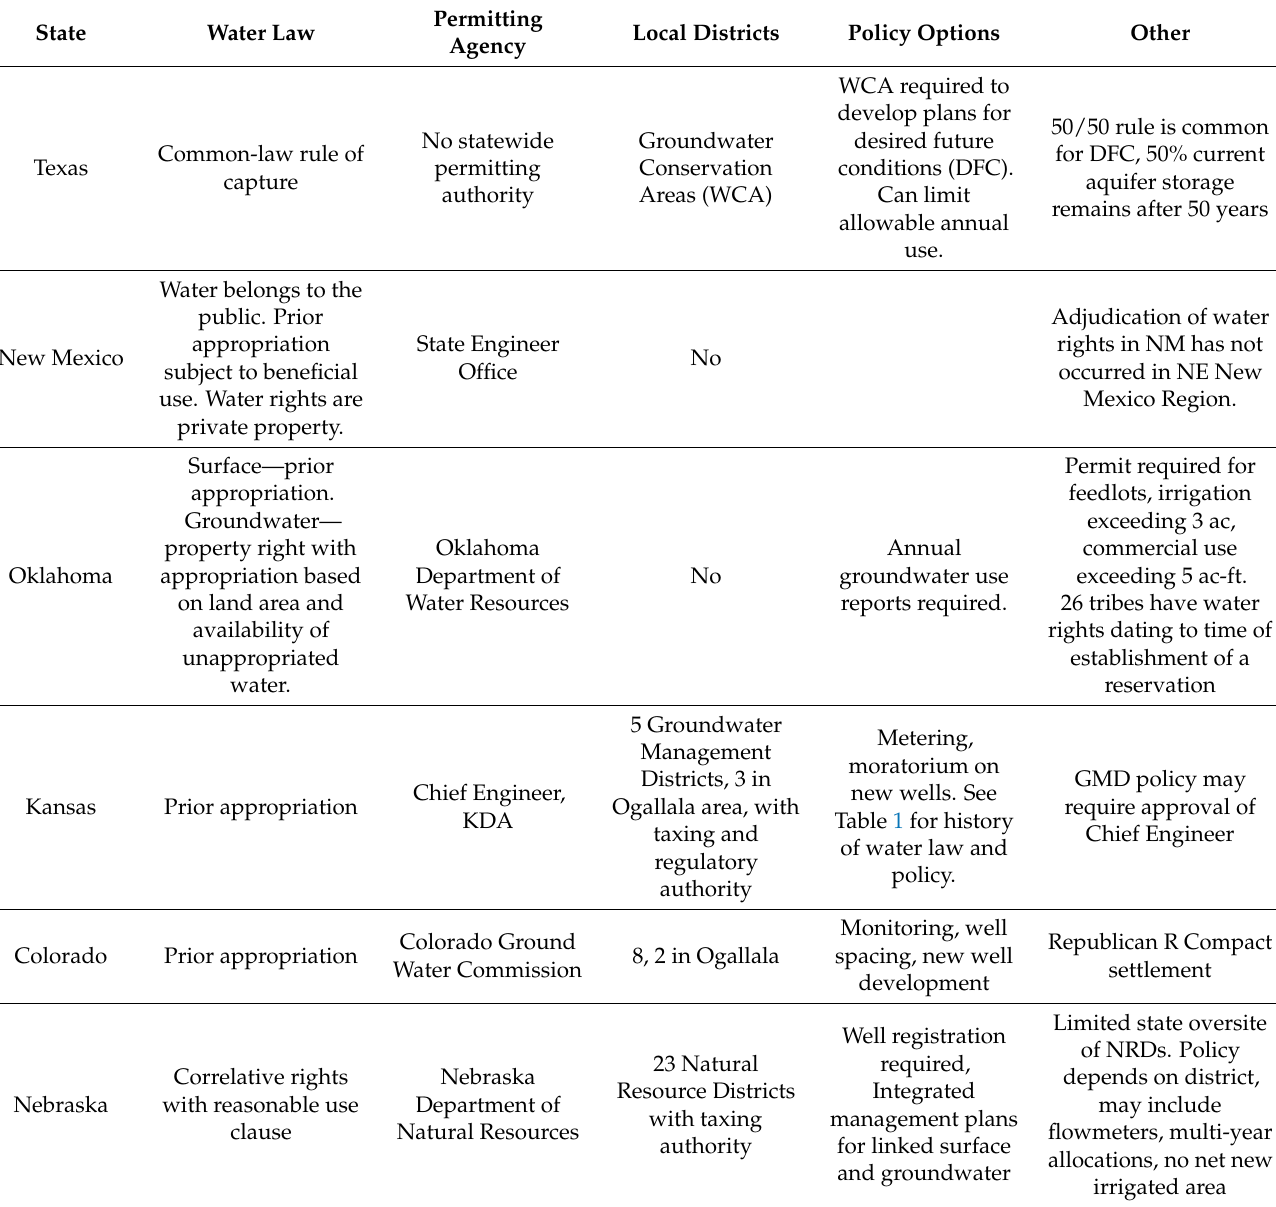
Table 2. Contrasting water policy in states overlying the Ogallala Aquifer. Sources: [17,61].